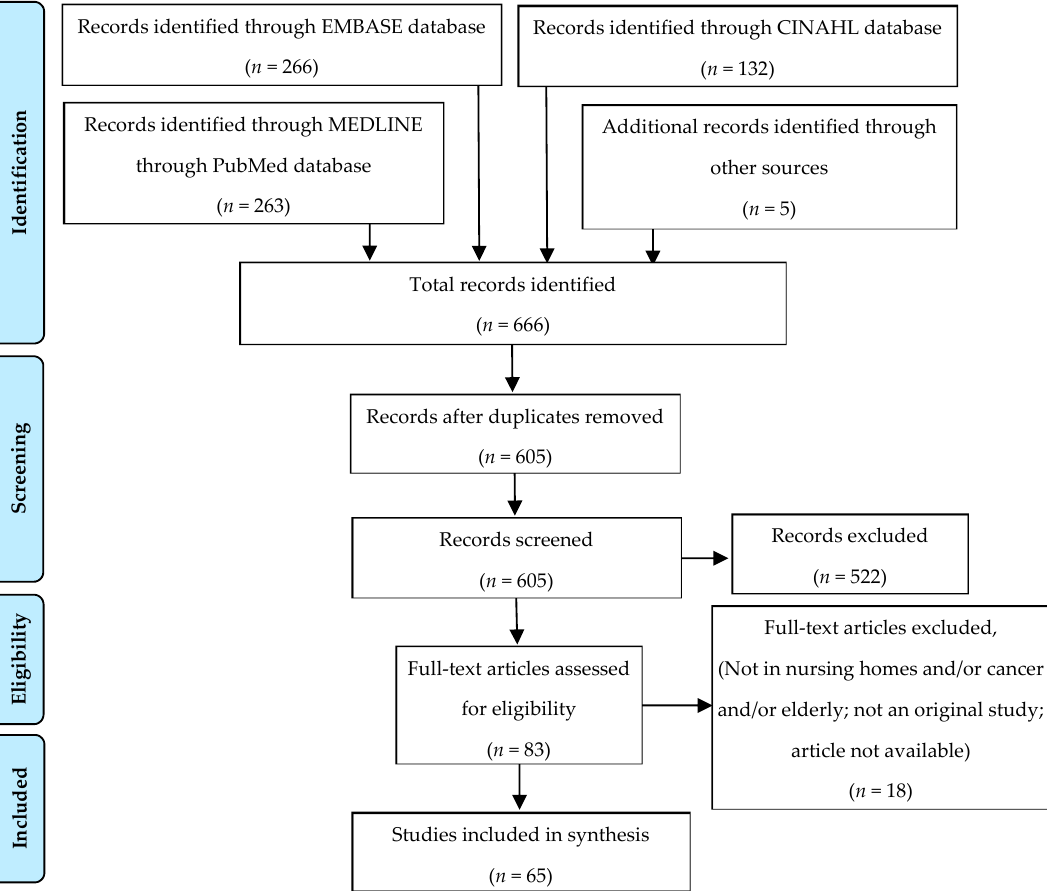
Figure 1. PRISMA flowchart summarizing the process for the identification of eligible articles.